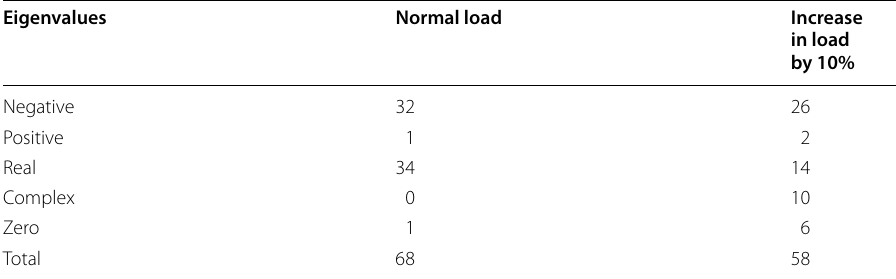
Table 7 Effect of damping on micro-grid with composite load Eigenvalues ζ Negative 15 Positive 2 Real Complex Total